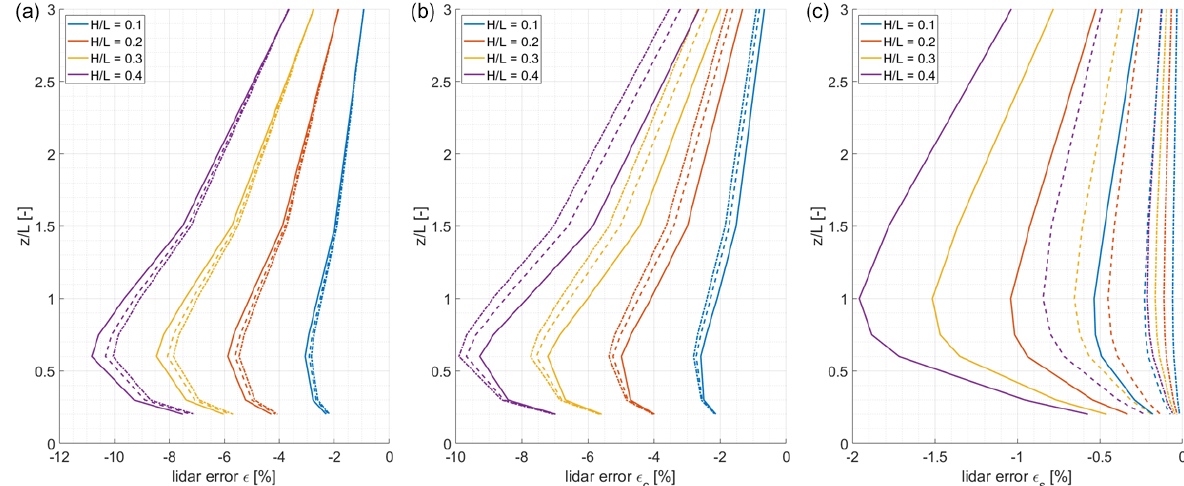
Figure 8. Lidar error ε (a) , ε c (b) , and ε s (c) in dependence of the H/L ratio for the half-cone opening angles ϕ of 30 ◦ (solid lines), 20 ◦ (dashed lines), and 10 ◦ (dot-dashed lines) between z/L ratios from 0 to 3 (left). Results are based on the potential flow model.